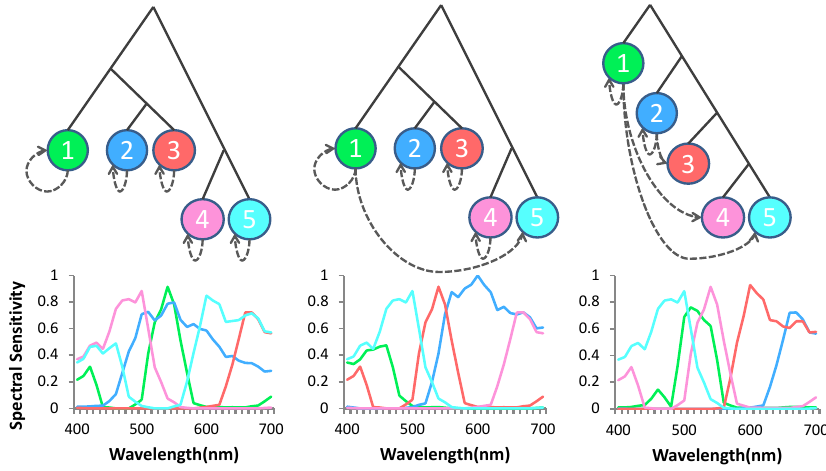
Figure 14. The optimized results under different noise levels (from left to right: SNR = 4, 16, 64